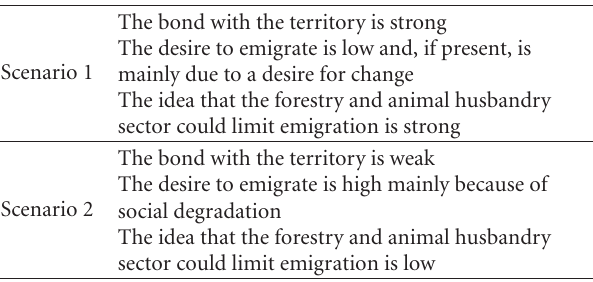
Table 4: Extreme scenarios regarding farmers’ links with the